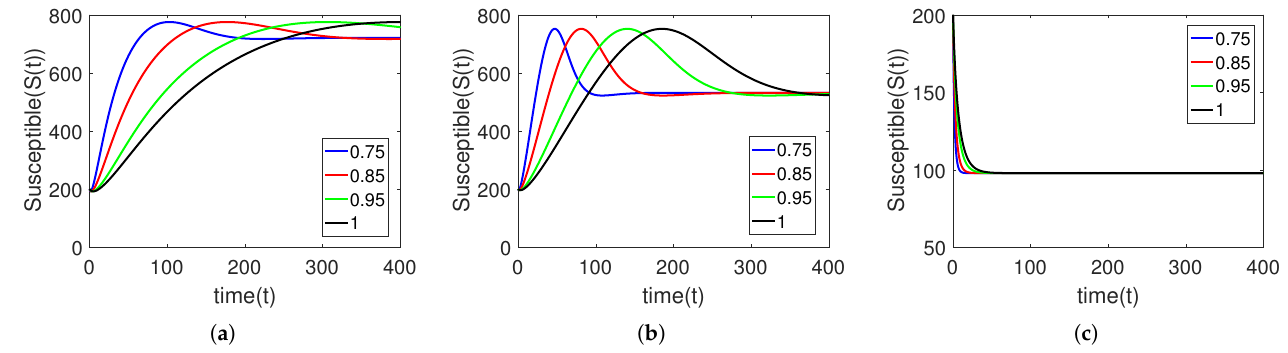
Figure 7. Graphical view ( a – c ) of a susceptible individual on different arbitrary orders γ = 0.75, 0.85, 0.95, 1 for initial data and time duration for TB model by taking the value of η = 0.0143,0.143,1.143.